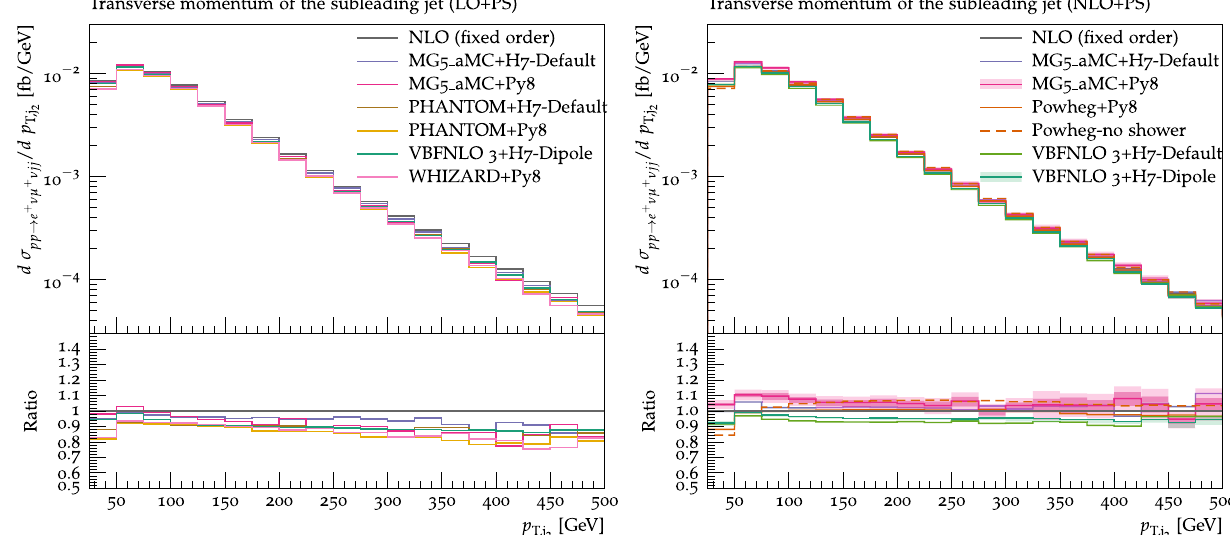
ties are shown, while for MG5_aMC + Pythia8 the darker and lighter bands correspond respectively to the nine-point scale uncertainty and the scale and PDF uncertainties combined linearly. The predictions are obtained in the fiducial region described in Sect. 3.3